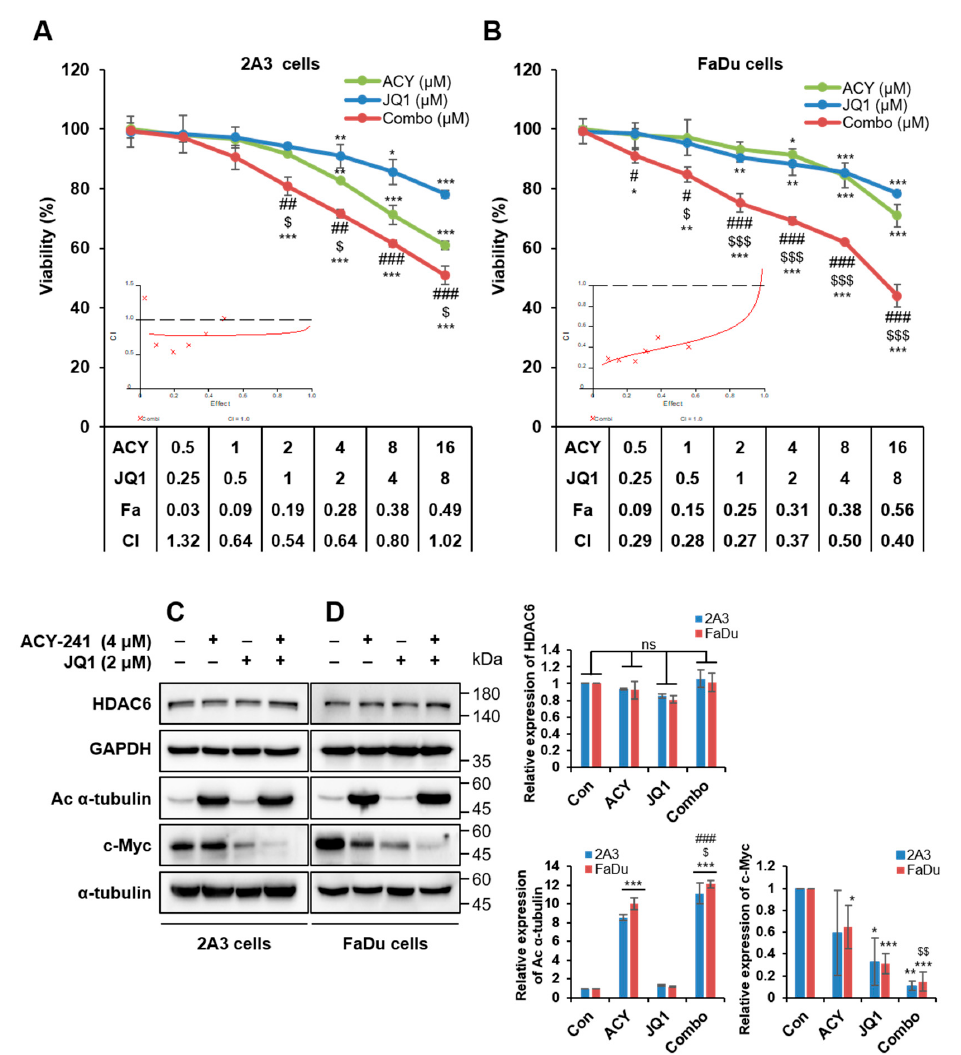
Figure 2. Combination treatment of ACY-241 and JQ1 synergistically decreases HNSCC cell viability. ( A , B ) ACY-241 and JQ1 were treated alone or in combination at a 2:1 ratio to 2A3 cells and FaDu